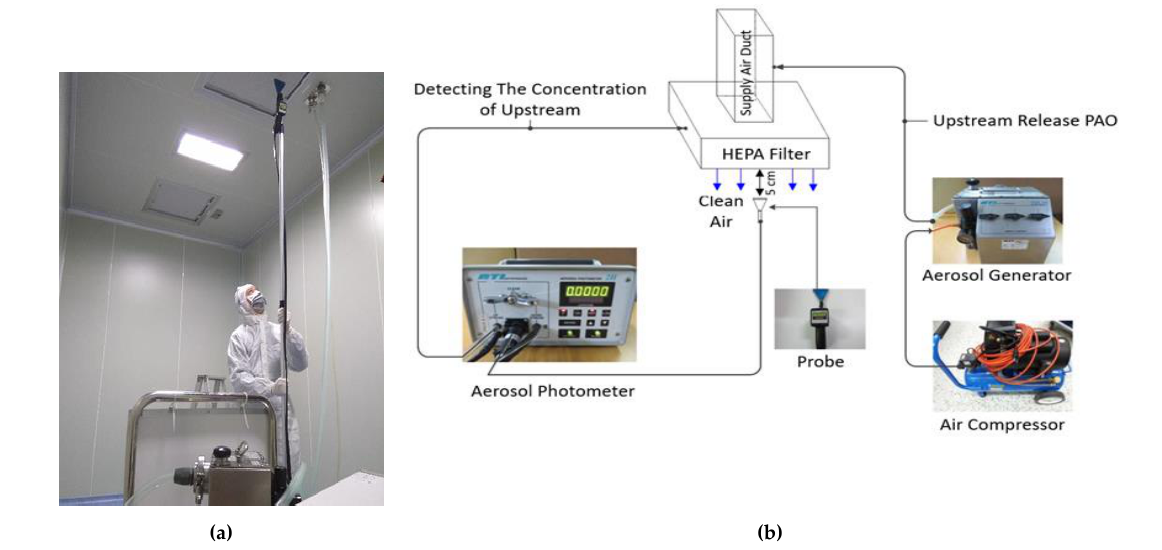
Figure 3. The HEPA leakage test; ( a ) snapshot; ( b ) schematic test diagram. Table 1. Apparatus for field measurement tests.